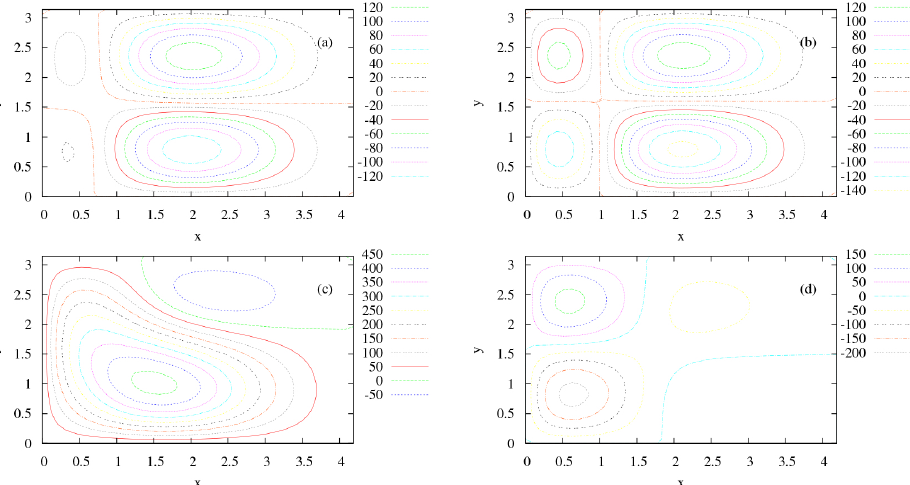
Fig. 2. Average streamfunction field of the ocean for δ = 0 . 001938 and θ ∗ = 0 . 077 (a) , 0.077 (b) , 0.10 (c) and 0 . 14 (d) , as obtained from a long integration of about 3 . 5 × 10 8 days. Note that (a) and (b) are obtained with the same parameters but different initial states in phase space.